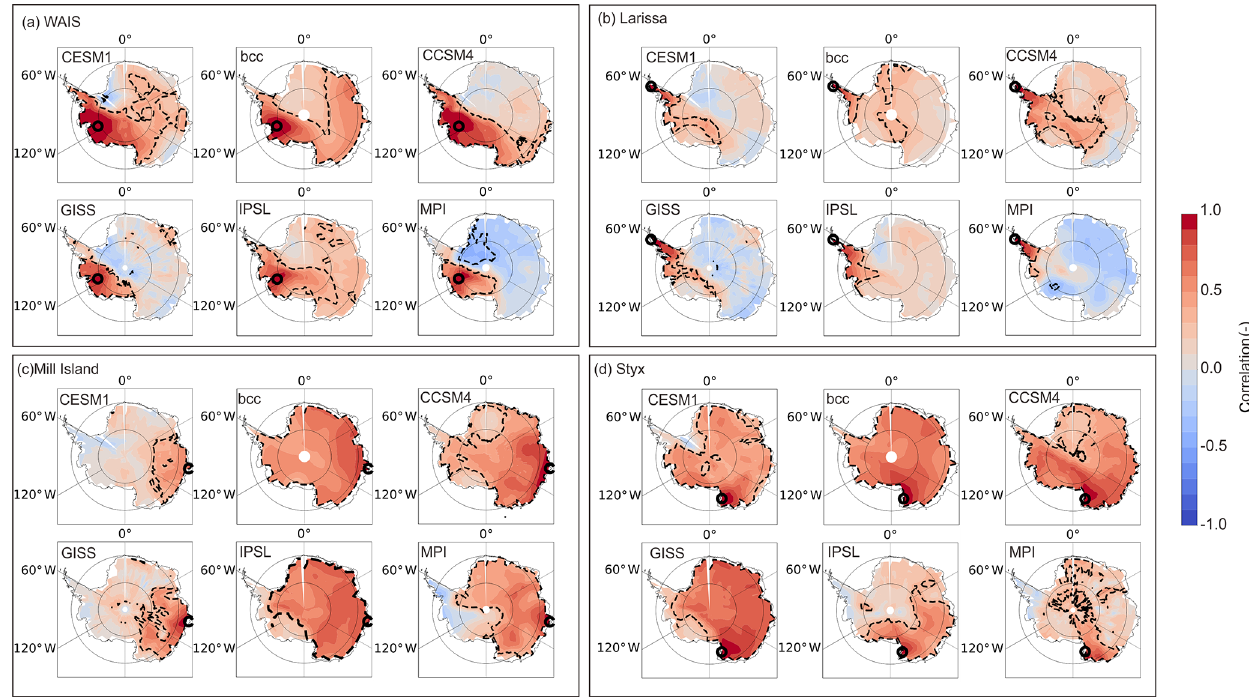
Figure 10. The correlation map showing the relationship between the temperature from 1950 to 2005CE at (a) WAIS, (b) Larissa, (c) Mill Island, (d) Styx, and other grid cells for each climate models. The black contour lines show correlation at the 99% significance level.